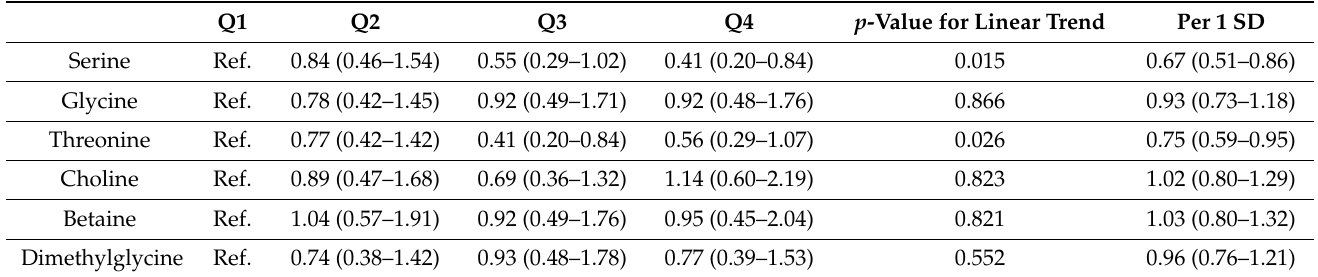
Table 4. Association * between plasma serine–glycine–threonine pathway metabolites and incident of peripheral artery disease (PAD).